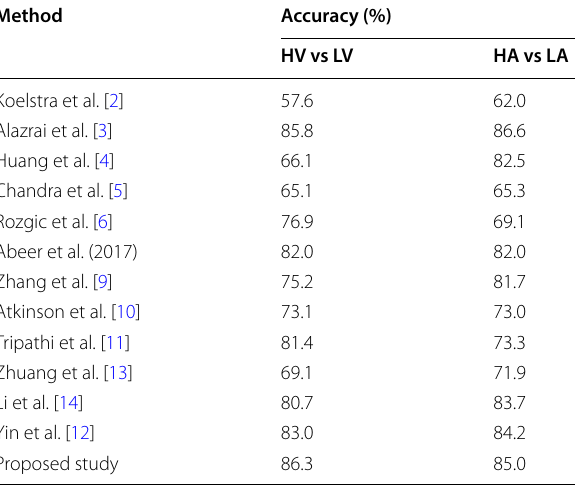
Table 12 Performance comparison of the proposed method with some of the state-of-the-art